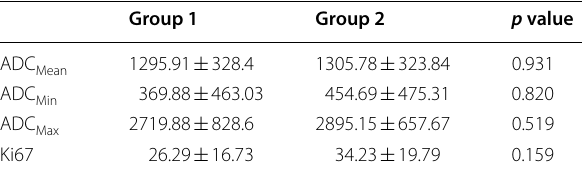
, ADC , ADC and Ki67 Mean Min Max